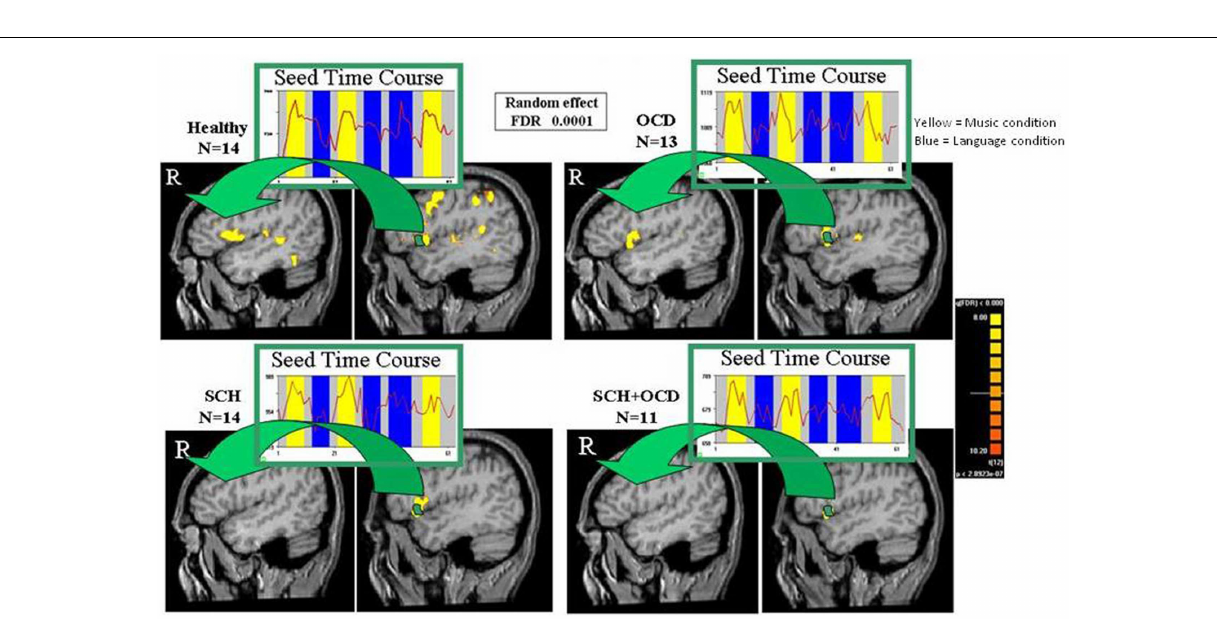
FIGURE 3 | Functional connectivity maps are shown . Functional connectivity maps revealed by averaged time-courses from left IFG for vg vs. blank (random effect, FDR of 0.0001). Maps of functional connectivity are